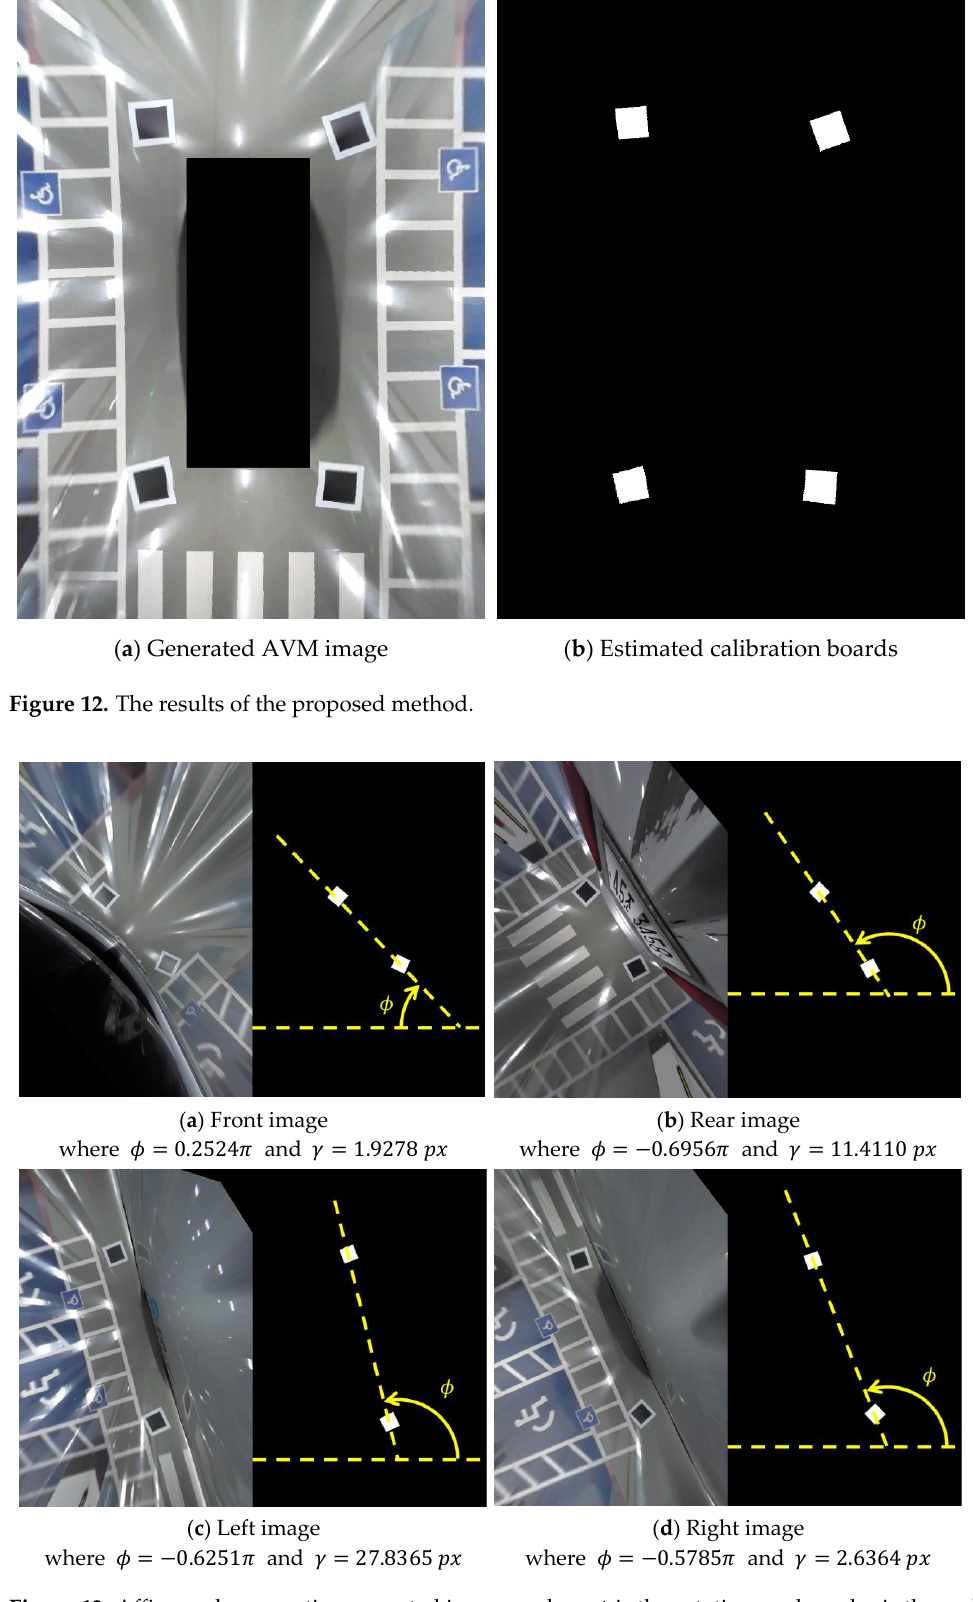
Figure 13. Affine and perspective corrected images, where 𝜙 is the rotation angle and 𝛾 is the scale value by the normalized parameters.